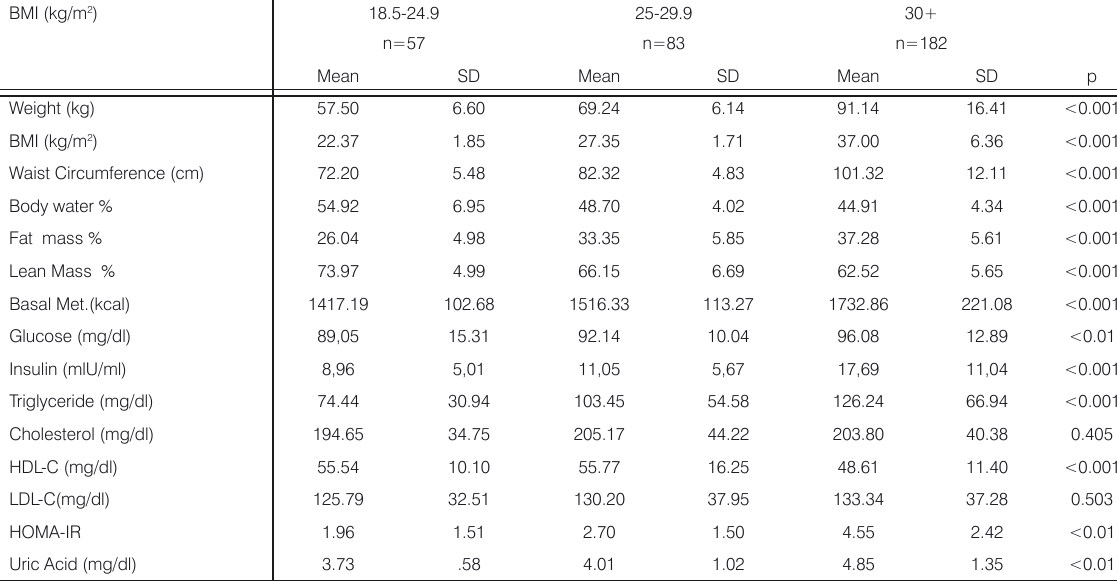
Table 1. Comparison of anthropometric measurements, body composition and biochemical parameters by BMI groups. BMI (kg/m 2